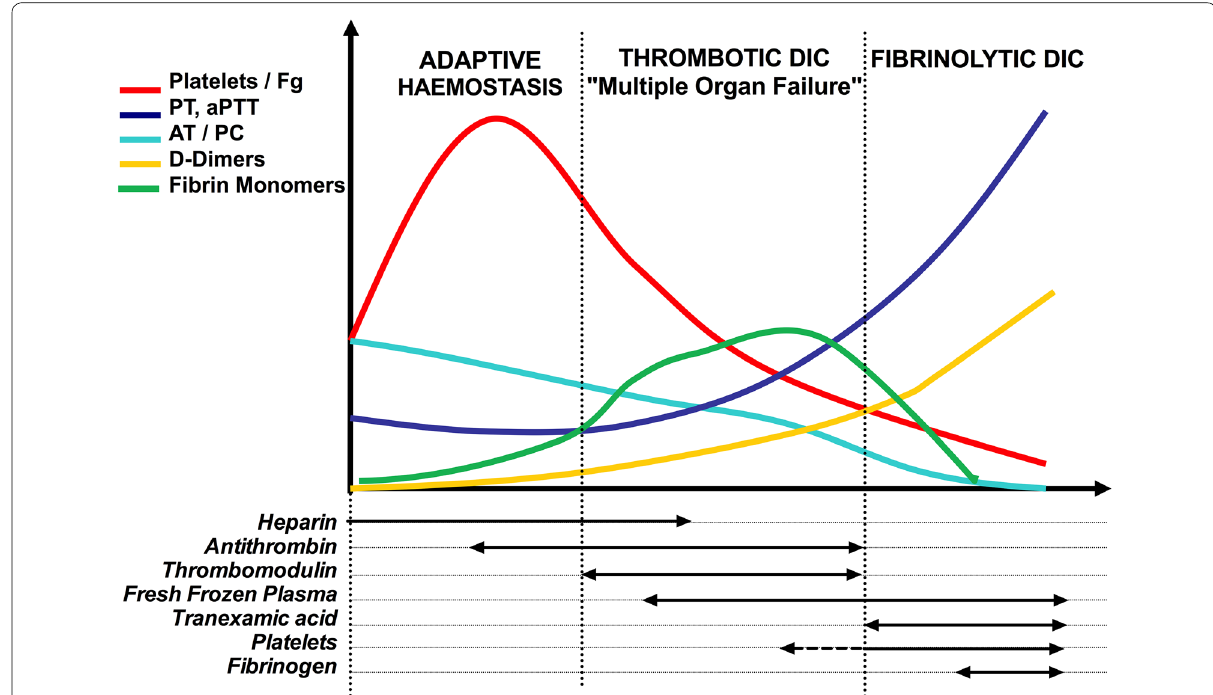
Fig. 2 Natural history of coagulation during infection and potential therapeutics. The first step is “adaptive haemostasis” associated with the systemic inflammatory syndrome. Platelet count increases and fibrinogen production is dramatically increased (red curve). Thrombin generation is initiated with slight shortening of PT and aPTT (dark blue curve) resulting in fibrin monomers generation (green curve). Natural anticoagulants, antithrombin and protein C are decreased by consumption and downregulation (light blue curve). Inhibition of fibrinolysis by PAI-1 results in low D-dimers (yellow curve). Only low-dose heparin (unfractionated or low molecular weight) could be recommended to prevent thrombosis (inferior part of the graph). Reduction of anticoagulants and continuous thrombin generation results in prolonged clotting times (PT and aPTT) and platelet and fibrinogen consumption that remain in the high normal range. Fibrin monomers increased due to sustained fibrin formation and defective pol- ymerisation by FXIIIa. D-dimers are moderately increased. This step can be called “thrombotic/multiple organ failure DIC” step and could be treated by natural anticoagulant infusion (antithrombin or soluble thrombomodulin) or fresh-frozen plasma. Later in the natural evolution of coagulation, consumption of all factors and platelets results in very low levels of fibrinogen, AT and PC, prolonged PT and aPTT and massive fibrinolysis with very high D-dimers. This “fibrinolytic DIC” step is characterised by oozing and massive bleeding, and supportive therapy associates fresh-frozen plasma and platelet transfusions, fibrinogen supply and tranexamic acid to prevent